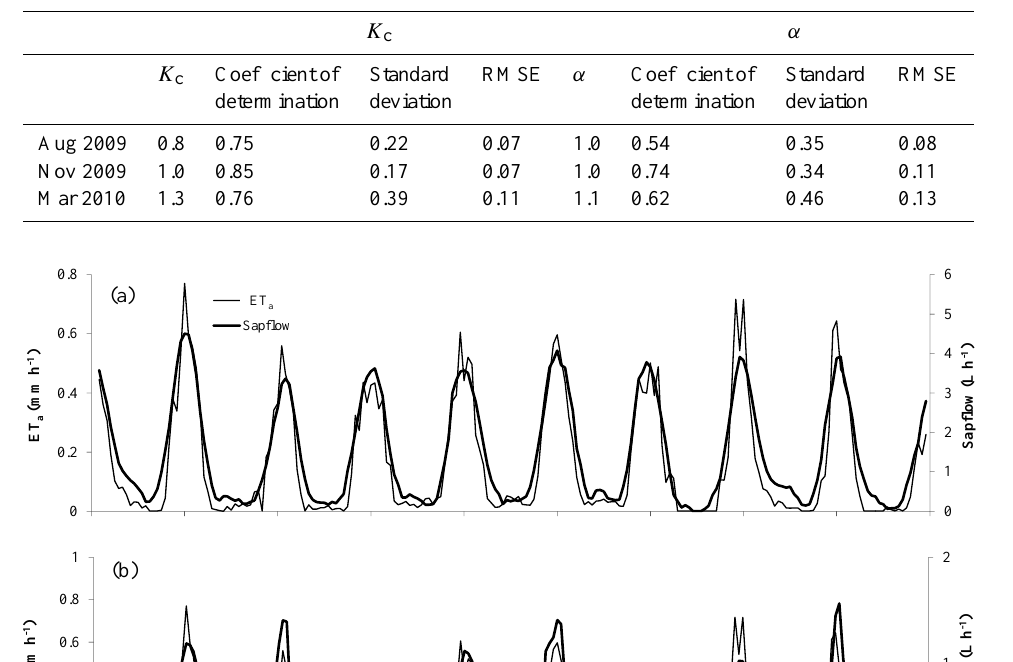
Table 2. Summary of the hourly crop coefficient K c and advective term α with standard deviation and root mean square error (RMSE) for each of the three field campaigns.